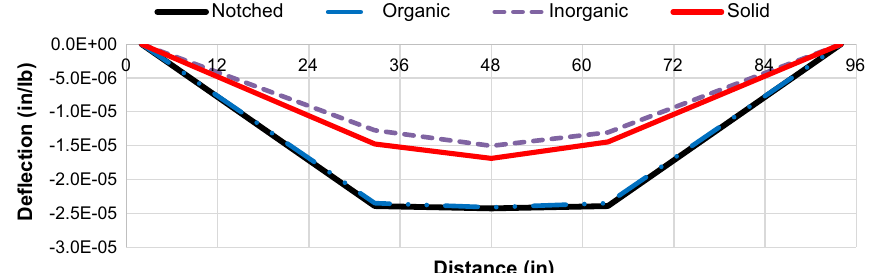
Fig. 14 Full-scale beam curvature comparison.